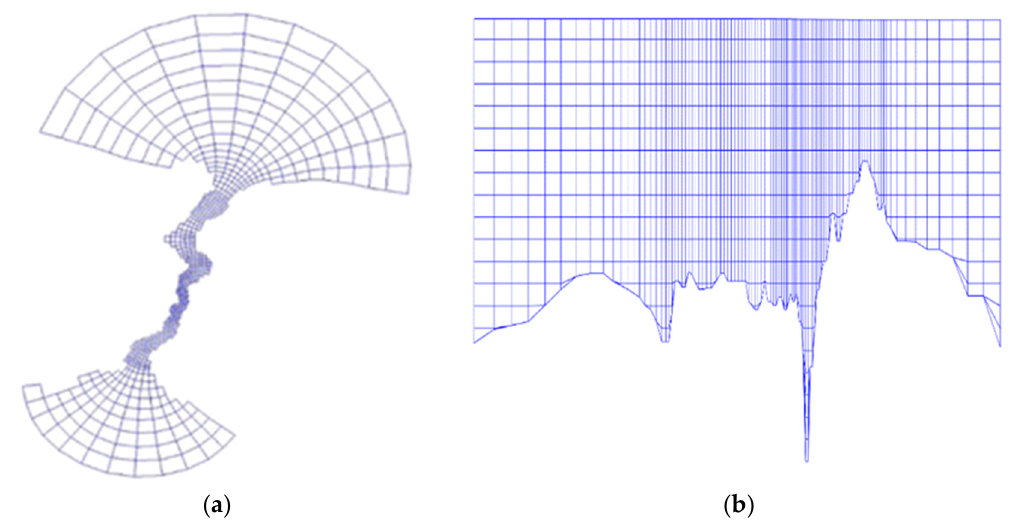
Figure 5. Hydrodynamic grid of the model in the ( a ) vertical and ( b ) horizontal directions.